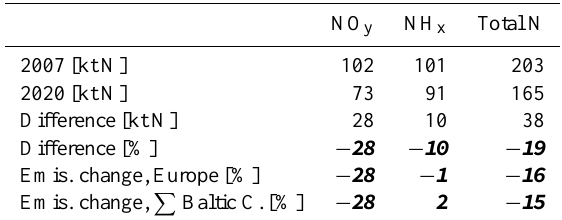
Table 2. The modelled deposition of NO y , NH x and total nitrogen (in ktonnesN) to the Baltic Sea based on 1998 meteorology and including present day emissions (2007) and projections for 2020. The resulting reduction in deposition is given in kt N and as a %- decrease. The latter can be compared to the %-decrease in emis- sions in Europe and in the countries bordering the Baltic Sea ( P Baltic